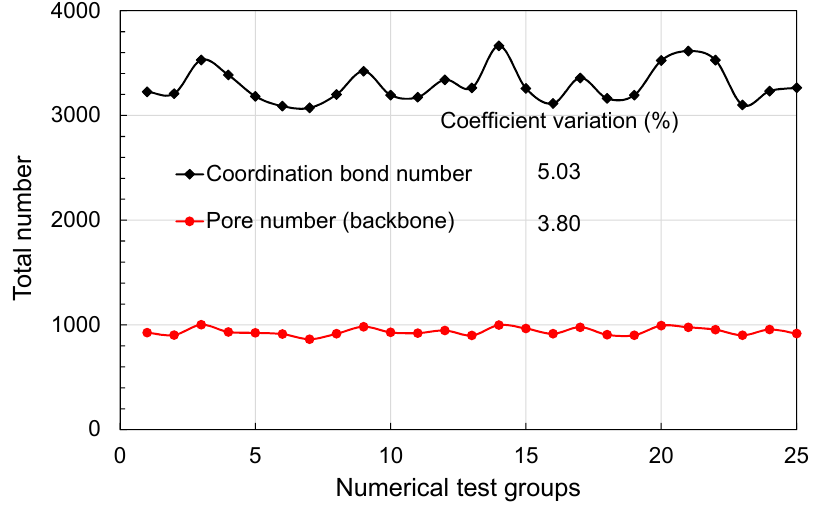
Figure 2. Statistic property of pore number and coordination number.